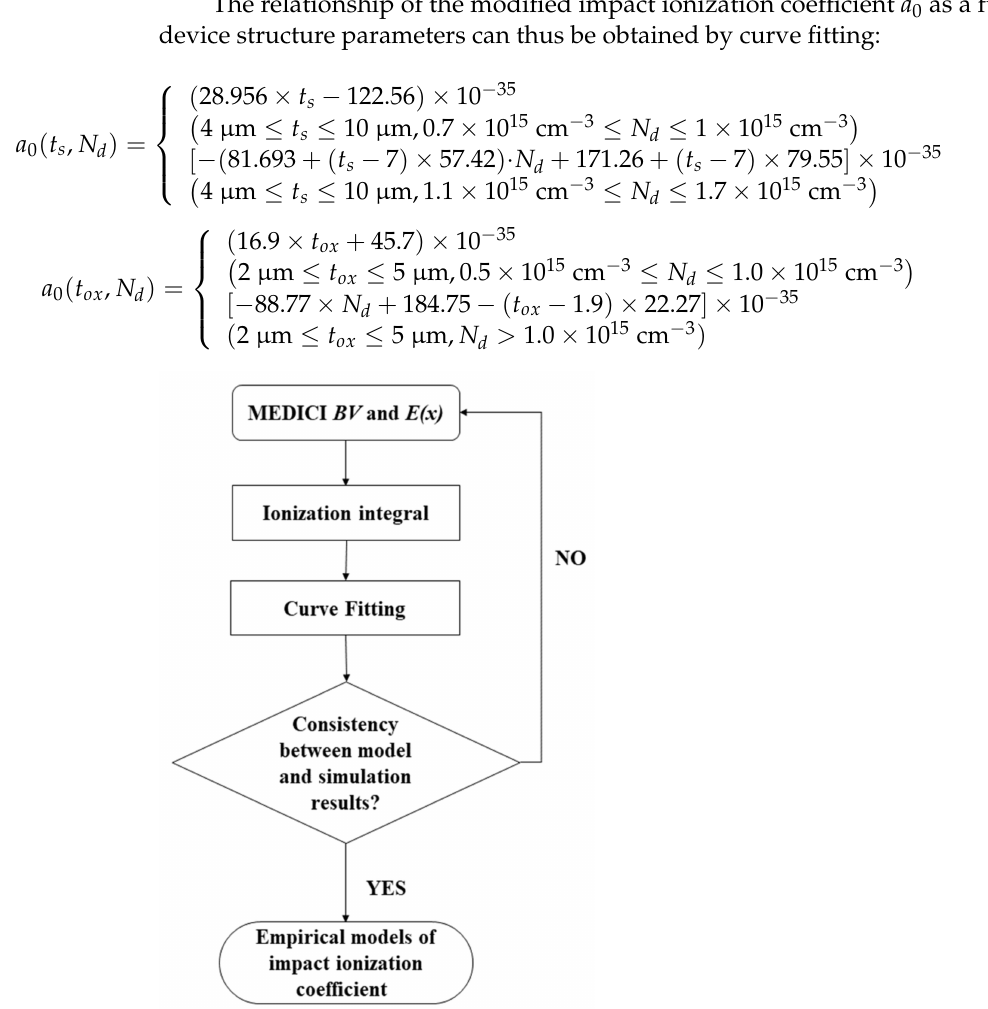
Figure 6. Impact ionization coefficient extraction